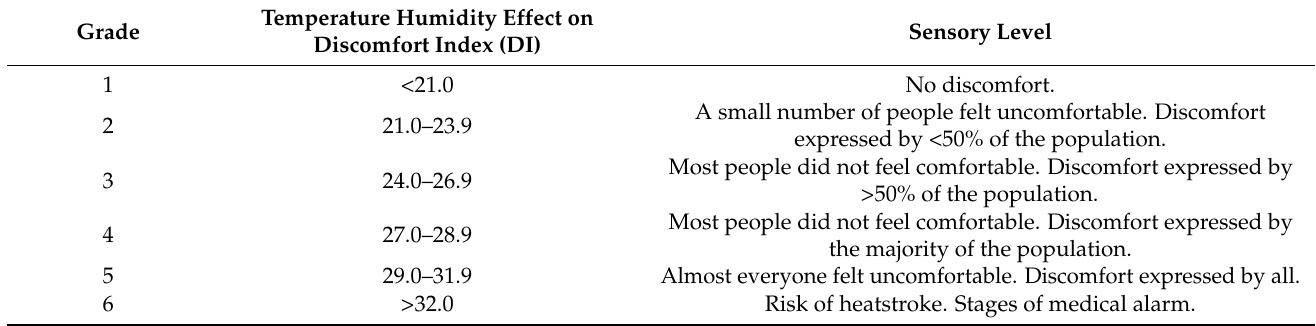
Table 3. Division of discomfort index and human